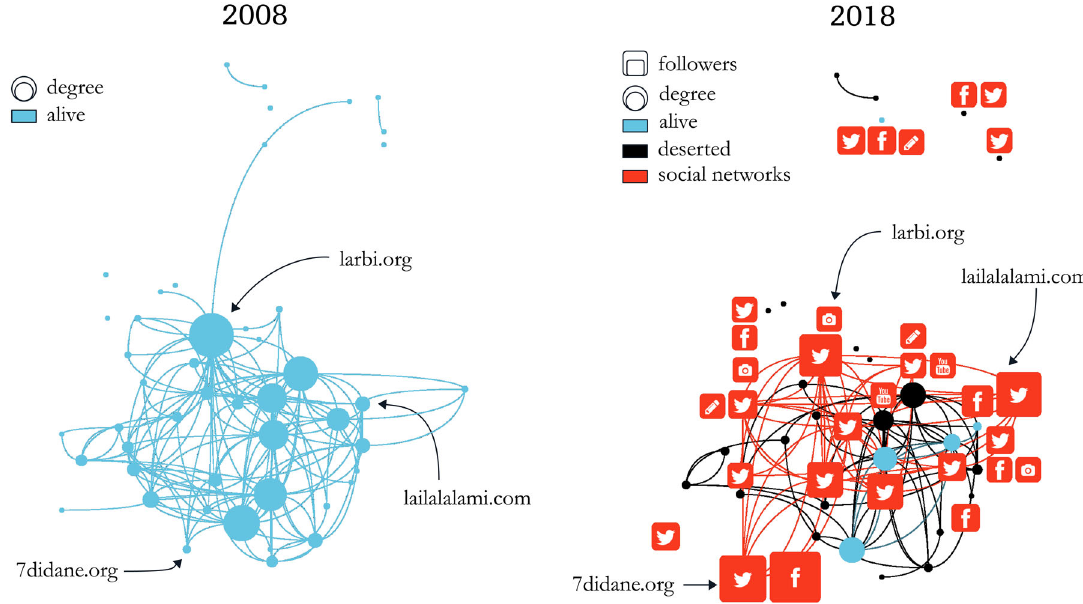
Fig. 4 A digital migration. The blogosphere in 2008 facing the blogosphere in